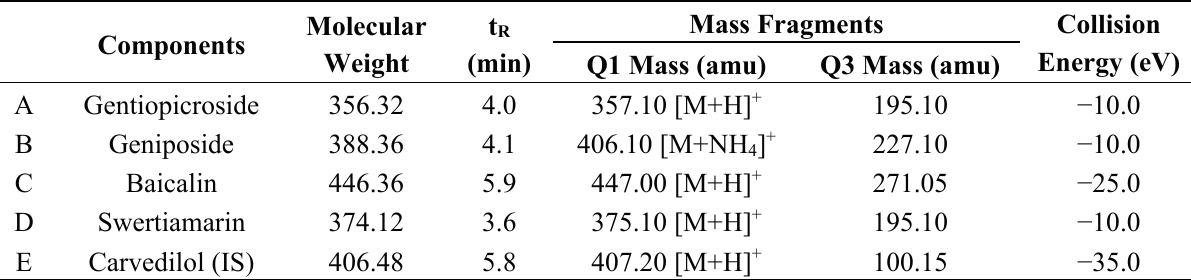
Table 1. The analytical conditions of LC-MS/MS for the identification of the four components. Molecular Components